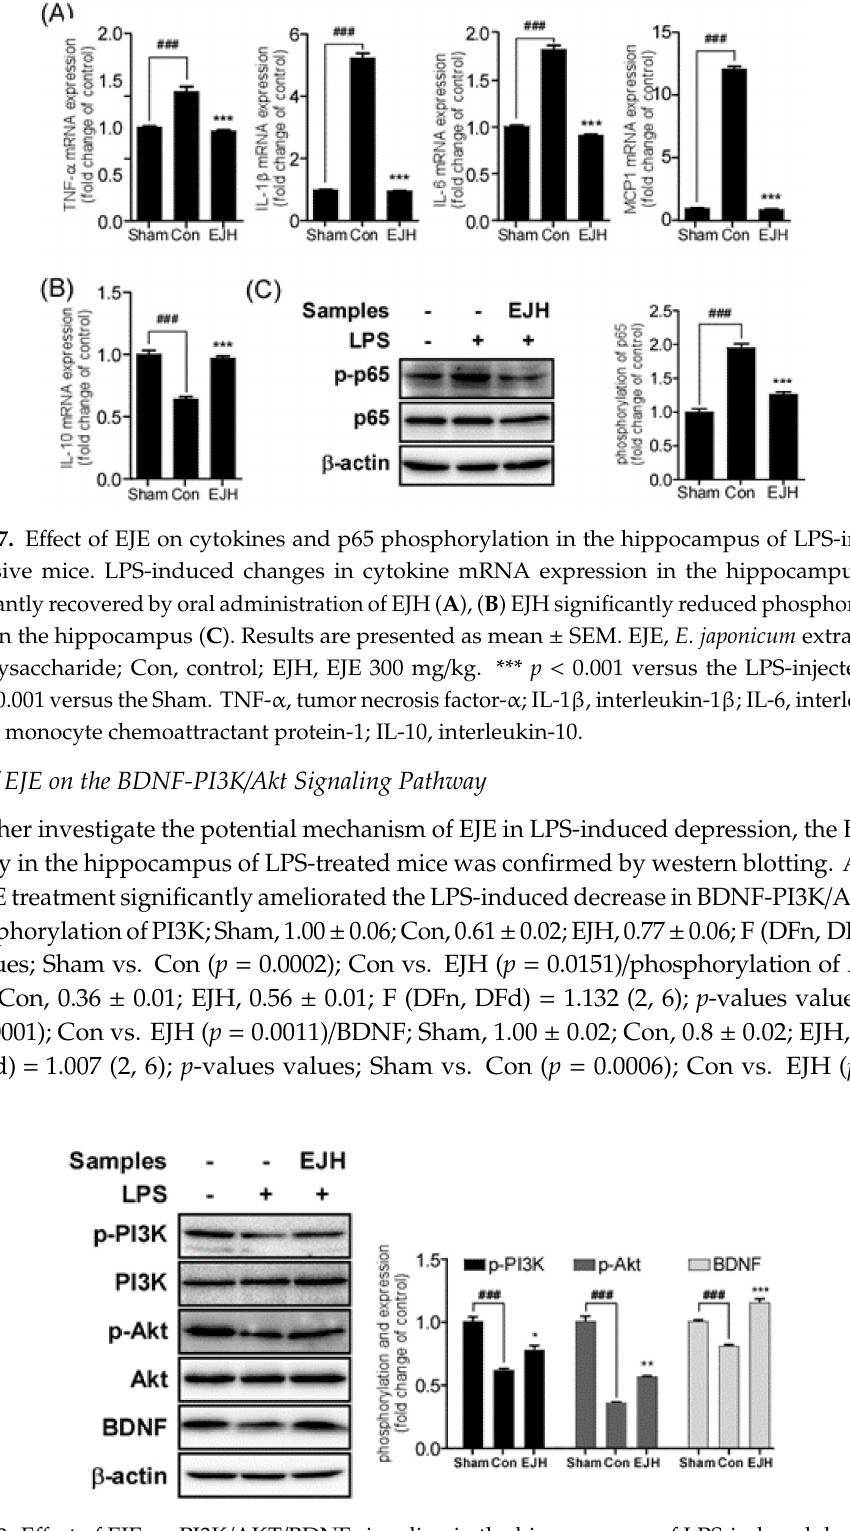
Figure 8. E ff ect of EJE on PI3K / AKT / BDNF signaling in the hippocampus of LPS-induced depressive mice. Although the PI3K / AKT / BDNF signaling was decreased by intraperitoneal injection of LPS, administration of EJH significantly increased PI3K / AKT / BDNF signaling in the hippocampus. Results are presented as mean ± SEM. EJE, E. japonicum extract; LPS, lipopolysaccharide; Con, control; EJH, EJE 300 mg / kg. *** p < 0.001, ** p < 0.01, and * p < 0.05 versus the LPS-injected Con; ### p < 0.001 versus the